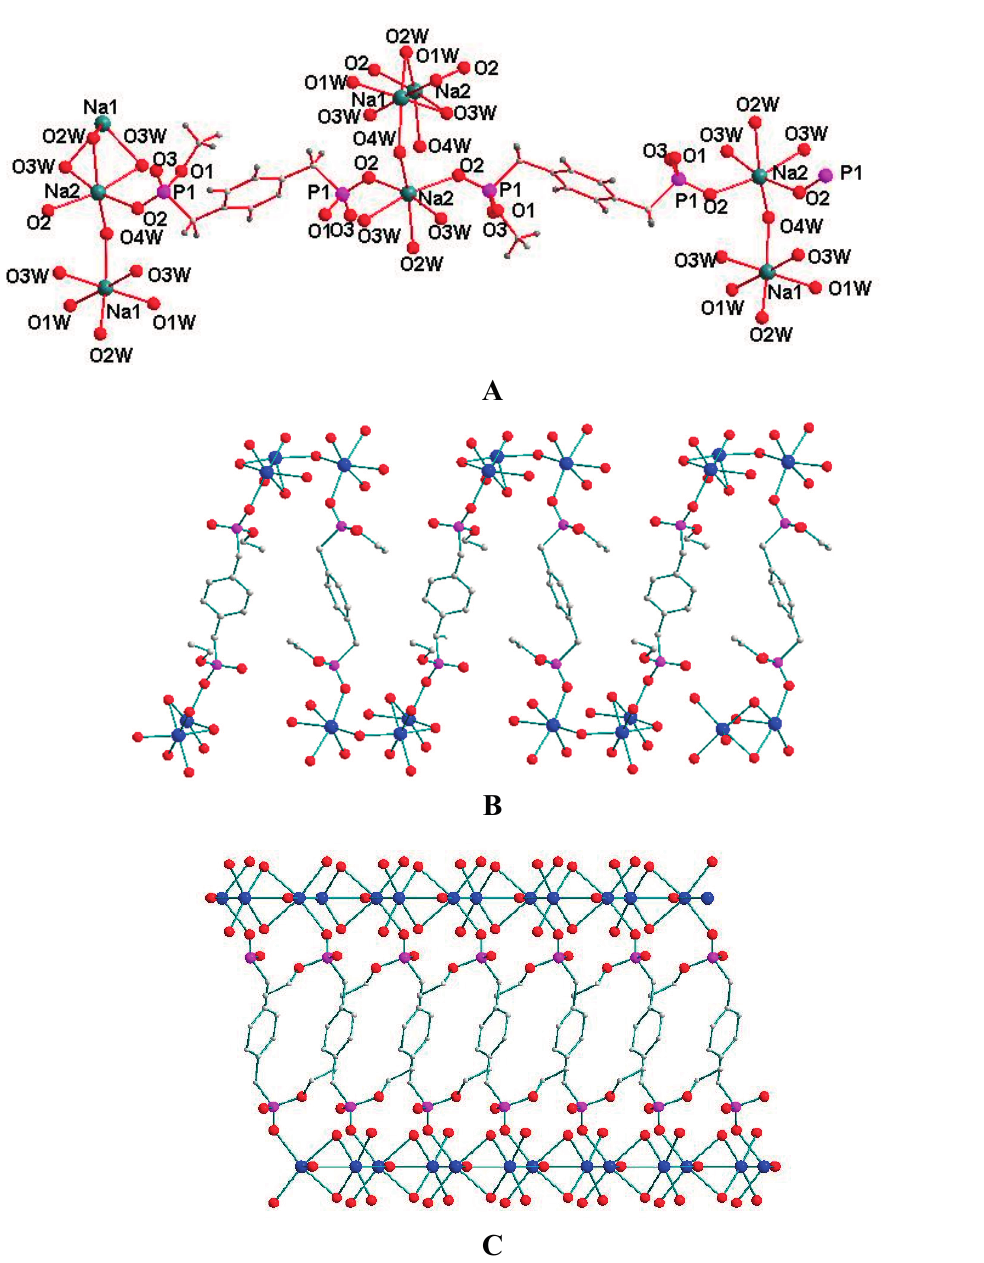
Figure 4. ( A ) Molecule structure of 4 with atomic numbering scheme; ( B ) 2D network in the unit cell and ( C ) 3D network coordination